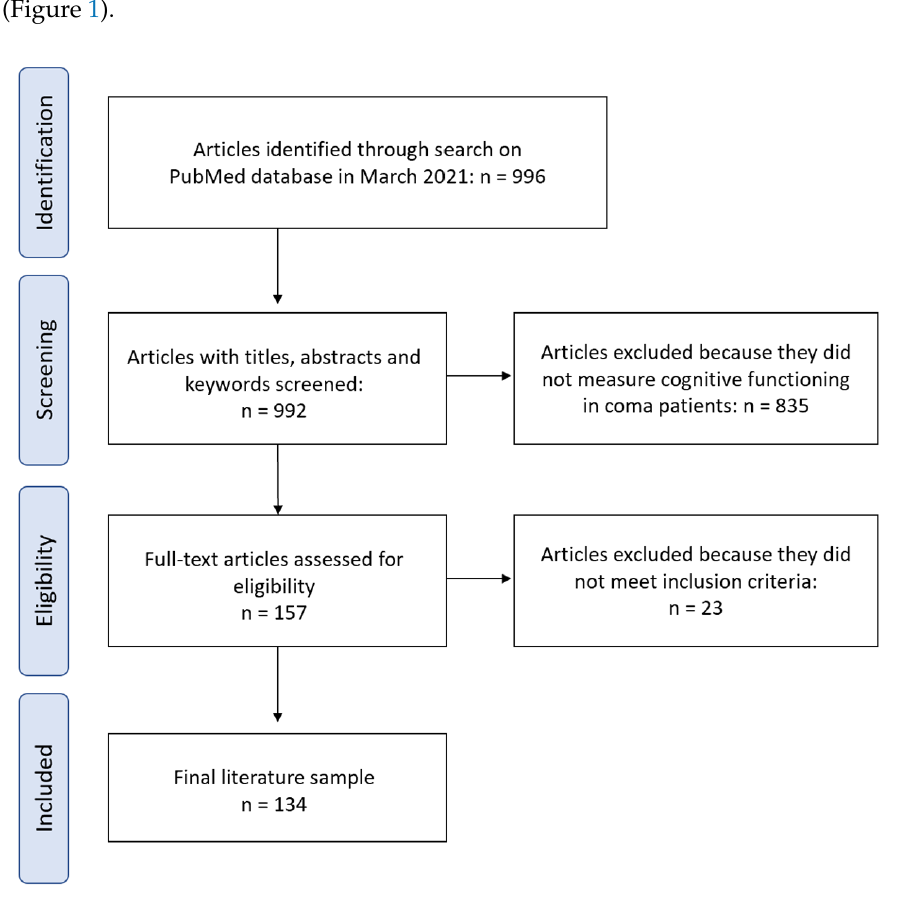
Figure 1. Flowchart outlining the protocol adopted in this narrative review.